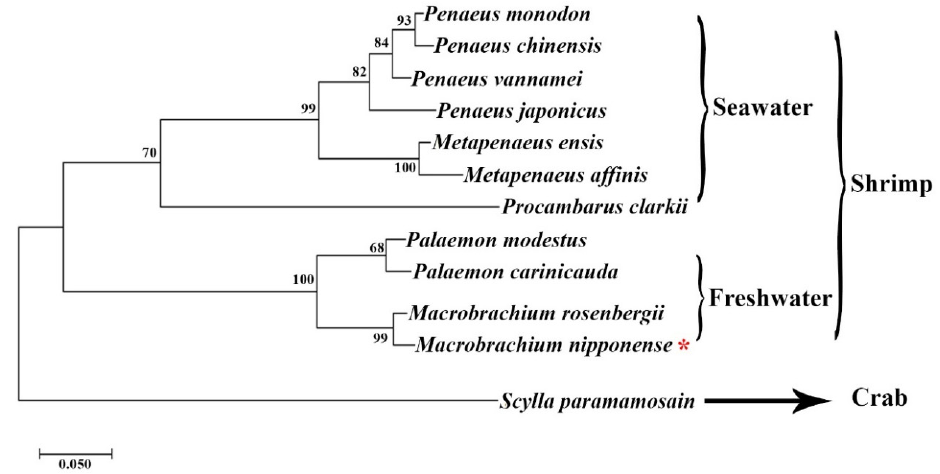
Figure 4. Phylo-genetic tree of CycB s from different organisms. Species names are listed on the right side of the tree. The red asterisk indicates M. nipponense .